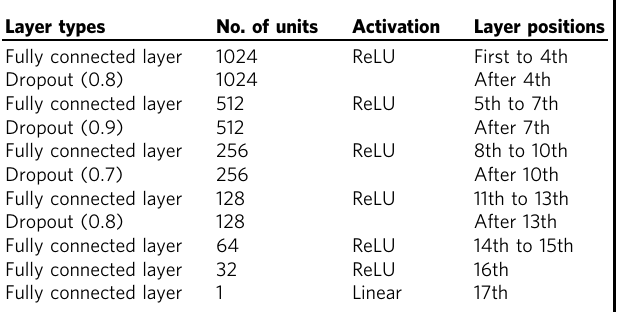
Table 4 ElemNet model architecture used for training different